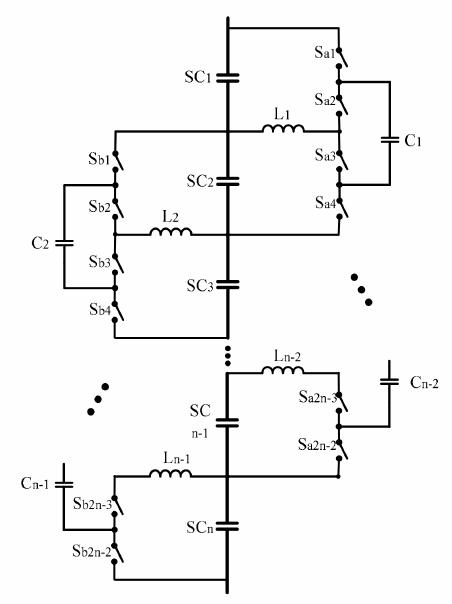
Figure 2. Proposed balancing